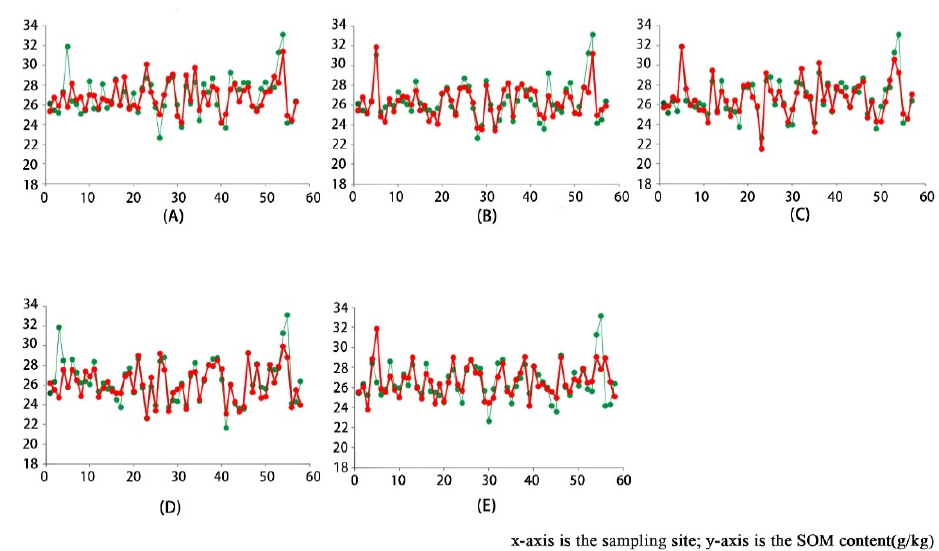
Figure 8. Model training results with different number of features (the red part refers to the model